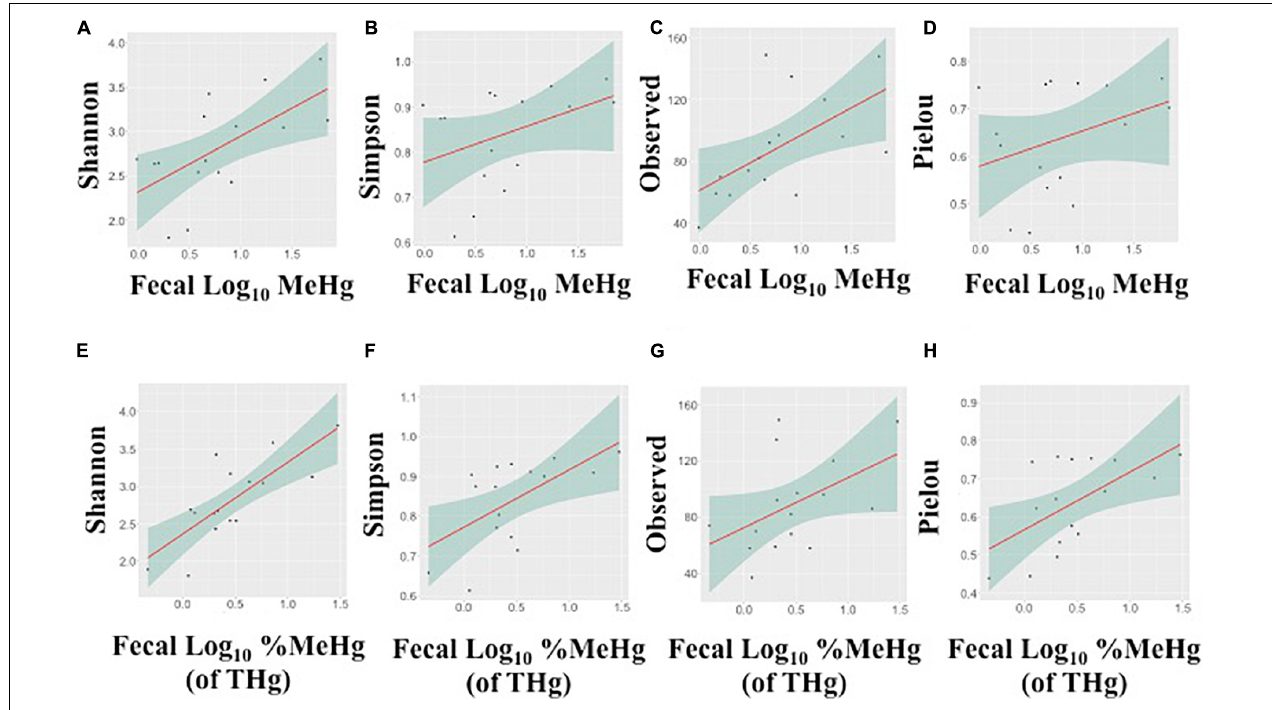
FIGURE 2 | Associations between the alpha diversity indices and fecal methylmercury (MeHg) (A–D) or %MeHg [of total mercury (THg)] (E–H) (both log 10 -transformed), including (A,E) Shannon’s diversity index, (B,F) Simpson’s diversity index, (C,G) the observed number of amplicon sequence variants, and (D,H) Pielou’s measure of evenness. Each plot includes the linear regression line ± standard error of the regression